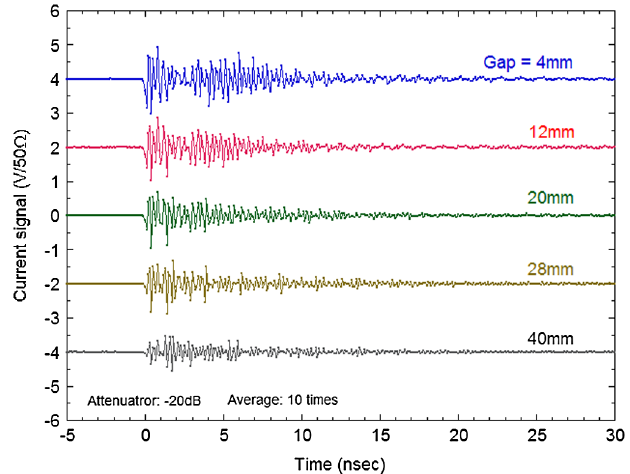
FIG. 10. Waveform caused by induction current. The gaps between the upper and lower detectors are indicated.